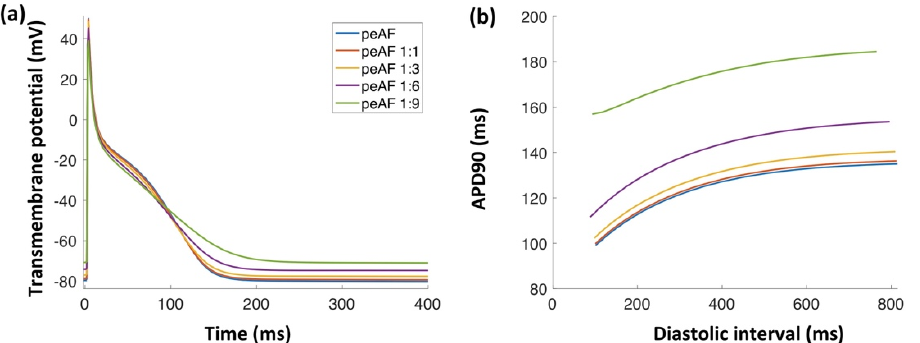
Figure 4. Fibroblast coupling effect on the myocyte action potential. ( a ) Uncoupled AF-remodeled myocyte action potential and four different numbers of myofibroblasts coupled to a single myocyte. ( b ) Action potential restitution curves for AF-remodeled myocytes and four different numbers of myofibroblasts coupled to a single myocyte.